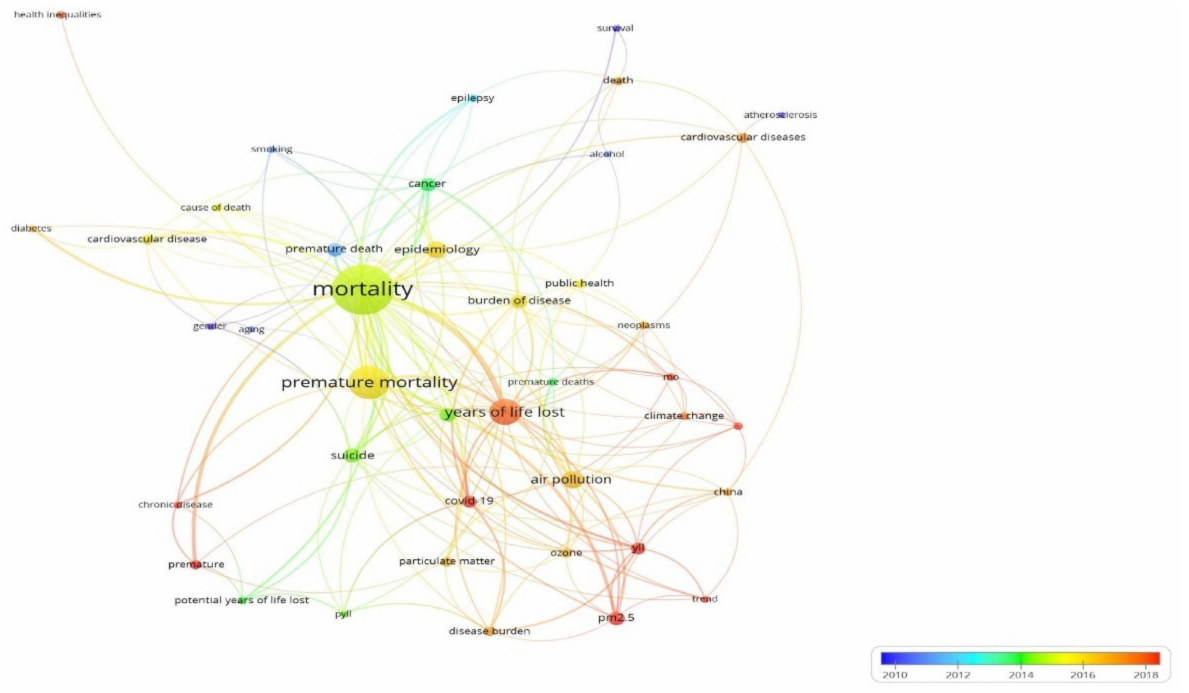
Figure 7. Co-occurrence keywords related to premature mortality. Note: The size of the label and the circle of an item is determined by the weight of the item. The higher the weight of the item, the larger the label and circle associated with it. The color indicates the timeline of year of